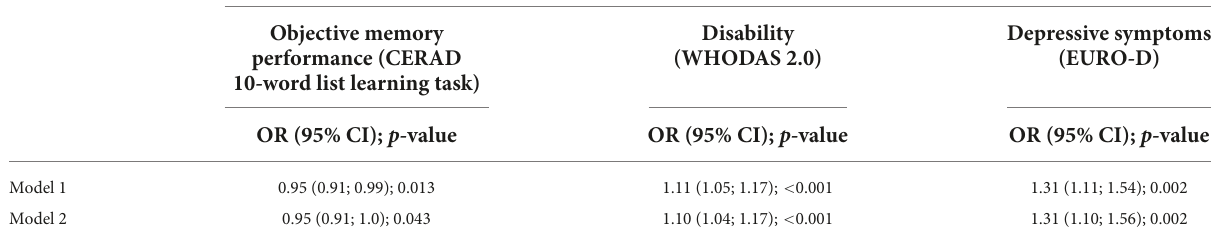
Model 1, logistic regression models showing the associations of SMD (outcome) with objective memory performance, disability, and depressive symptoms (predictors). Model 2, logistic regression models showing the associations of SMD (outcome) with objective memory performance, disability, and depressive symptoms (predictors) and adjusting for age, sex, and